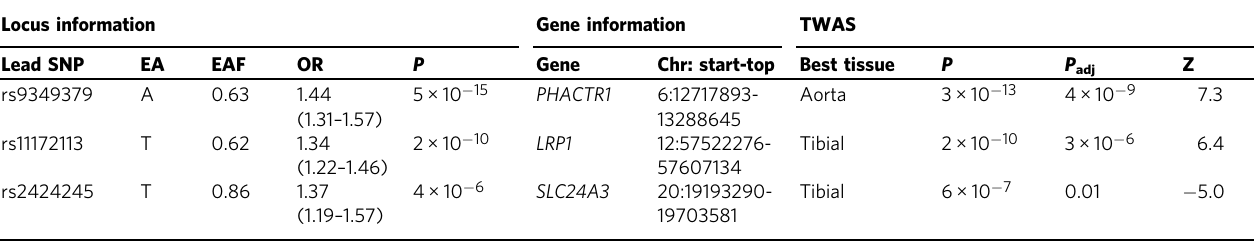
The table P values ( P ) and Z scores ( Z ) obtained in the trancriptome-wide association based on gene expression models from GTEx in tibial artery, aorta and coronary artery and GWAS. For each gene, only the best TWAS association is shown. All genes with Bonferroni adjusted P value below 0.05 are reported. FMD GWAS association for the best SNP in the locus is indicated.